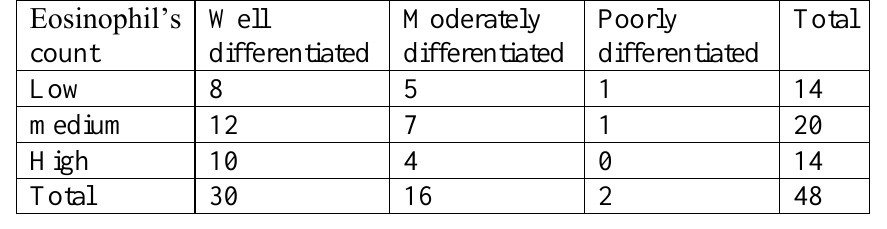
Table 3: Correlation of stromal eosinophilia in conventional squamous cell carcinoma with histological grade (degree of differentiation)